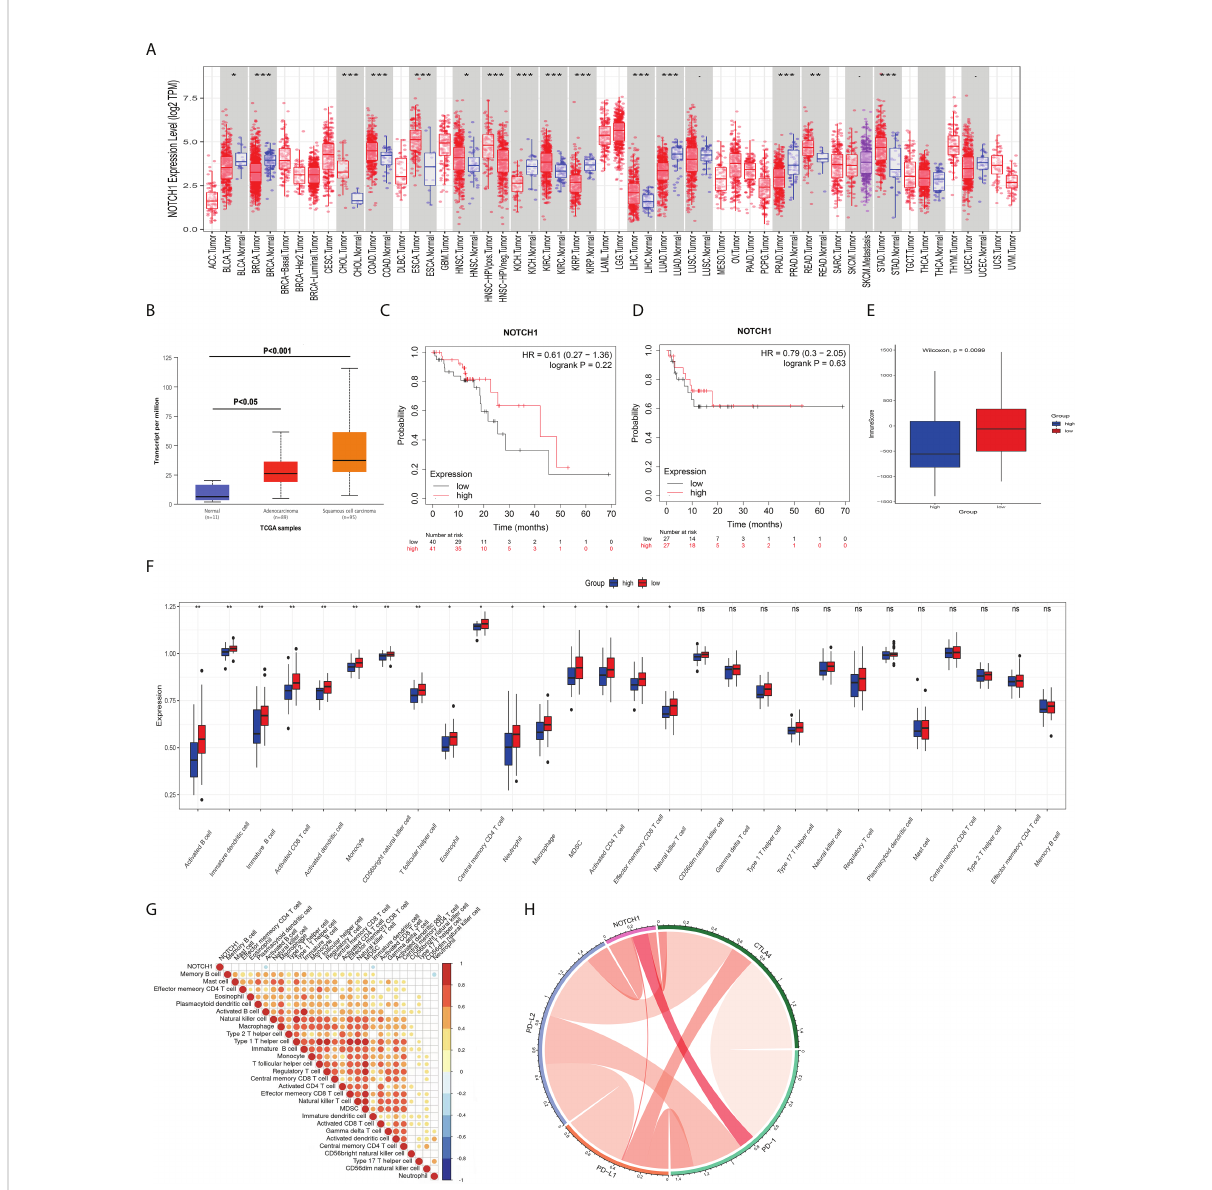
FIGURE 6 NOTCH1 is correlated with a few immunotherapy-related cells. (A) Expression of NOTCH1 in different types of cancers and their normal tissues. (B) NOTCH1 was signi fi cantly upregulated in esophageal cancer, especially in ESCC. C and D: There were no signi fi cant differences on the overall survival (C) and recurrence free survival (D) between the high levels of NOTCH1 and the low levels of NOTCH1 in ESCC patients. (E) The immune score was signi fi cantly decreased in the group with high NTOCH1 expression in ESCC. (F) Several immune cells, including activated B cell, activated CD8 T cell, activated dendritic cell, and CD56bright natural killer cell, were signi fi cantly enriched in the group with low NTOCH1 expression in ESCC. (G) Expression of NOTCH1 was negatively correlated with activated B cell and immature dendritic cell. (H) There were no signi fi cant relations between NOTCH1 and the four immune checkpoint molecules in ESCC. *P<0.05, **P<0.01, ***P<0.001, and ns,